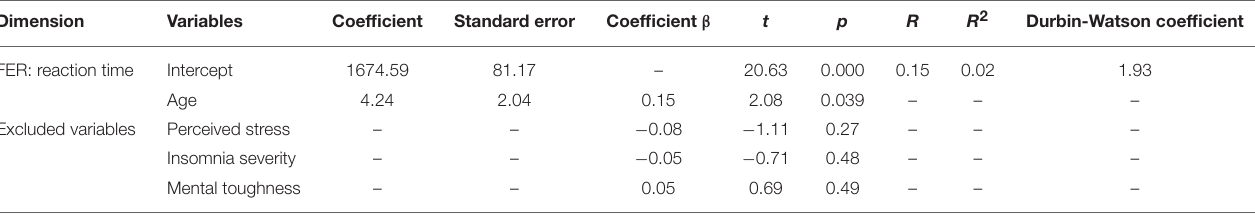
TABLE 3A | Multiple linear regression with facial emotion recognition reaction time as dependent variable, and age, perceived stress (PSS), insomnia severity (ISI), and mental toughness as predictors. Dimension